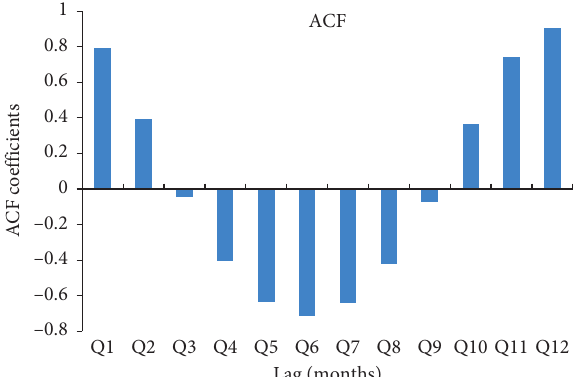
Figure 5: The autocorrelation function (ACF) coefficient graph of monthly